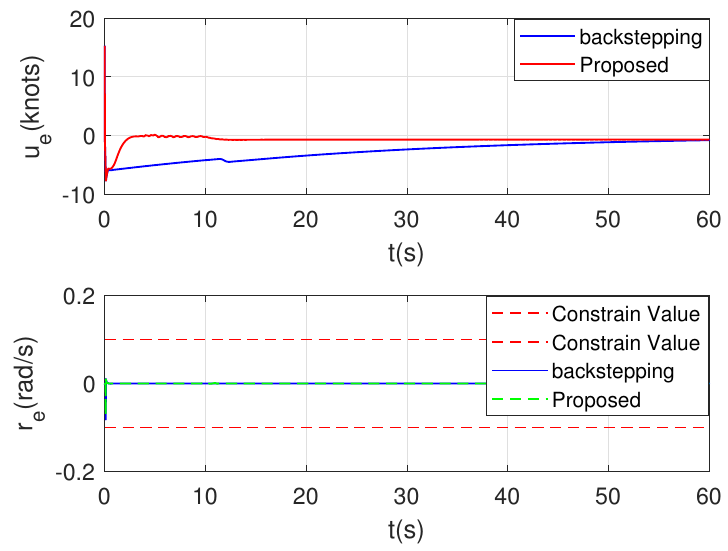
Figure 8. Surge speed error and yaw rate error of trajectory